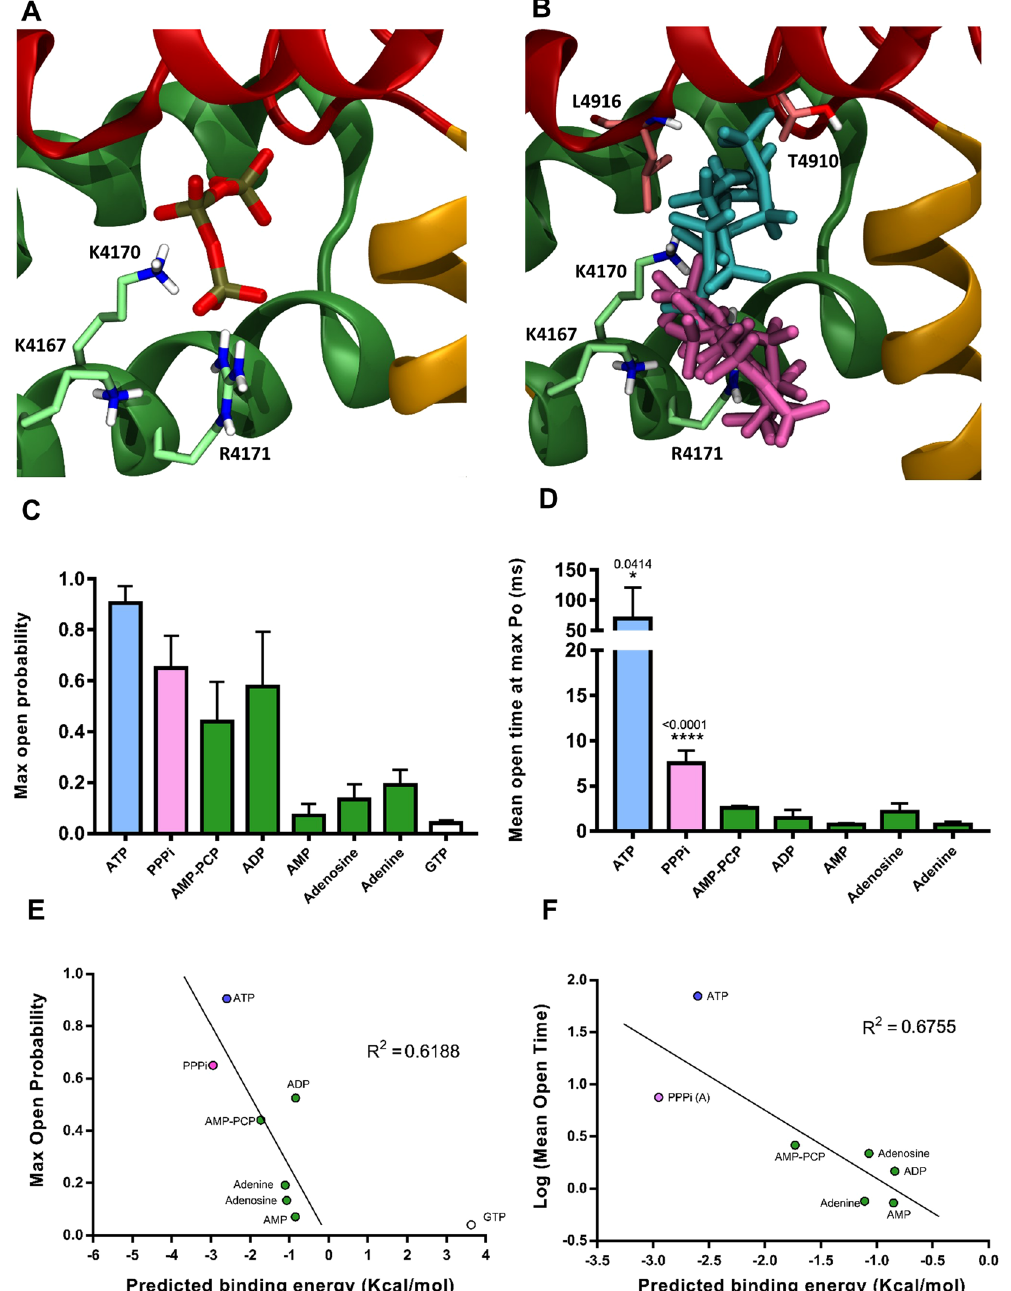
Figure 6. PPPi docking into the RyR2 ATP site and summary of the effects of ATP analogues on RyR2 gating. ( A ) A representative pose from the lowest energy cluster for docking of PPPi into the RyR2 ATP site. The residues R4171, K4167 and K4170 are indicated. ( B ) Poses from two clusters for docking PPPi into the RyR2 ATP site. Four poses from each cluster are shown, the ATP-like cluster is shown in pink, while the cluster binding deeper in the pocket (with lower energy) is shown in cyan. Residues that appear to interact with these poses are also indicated. ( C ) Comparison of the ability of ATP and other adenine or phosphate containing molecules to increase Po. The maximum Po obtained in single-channel experiments (with 10 μ M free Ca 2 + ) by the compounds indicated in the bar chart is shown. ( D ) The mean open time at maximum Po for ATP and various fragments or analogues of ATP is shown. Only ATP and PPPi significantly increased mean open time relative to control (for ATP p = 0.0414 and for PPPi p < 0.0001). The data includes results from this study and from our previous work on adenine nucleotides performed under identical experimental conditions only 3,6,10,39 . The error bars are SEM (n ≥ 4). Correlation between the maximum Po ( E ) or the mean open time ( F ) obtained for each ligand and Autodock predicted mean binding energies (kcal/mol) for the various ligands listed. As GTP did not bind in the ATP site, the point is shown, but the value has not been included in the statistical analysis. The Pearson correlation coefficients (R 2 ) were 0.6188 and 0.6755, and the p values were 0.0359 and 0.023, respectively, thus showing significant correlation (p <